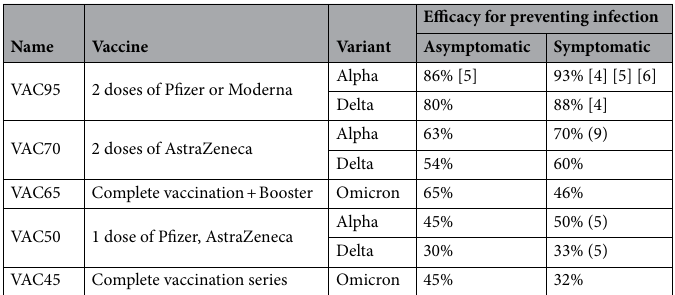
Table 1. The simulation package is publicly available at https:// ictr. github. io/ covid 19- outbr eak- simul ator/.